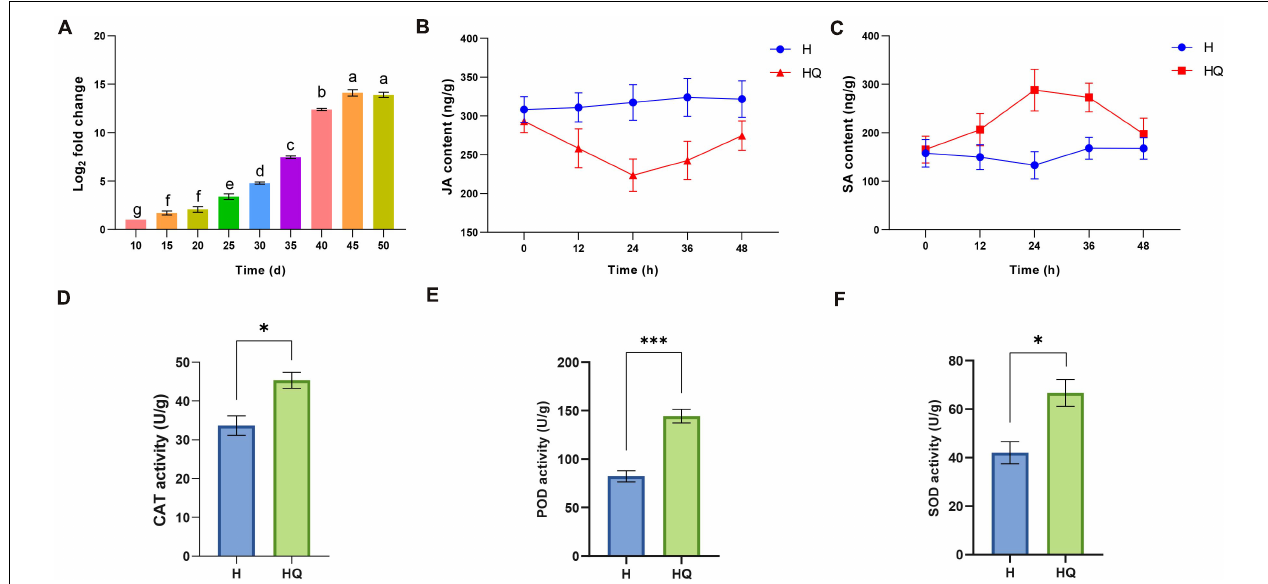
FIGURE 1 | Determination of tomato chlorosis virus (ToCV) content, plant hormones and antioxidant enzyme activity. (A) Accumulation of tomato chlorosis virus in tomato plants at different time points. (B,C) The JA and SA content in control and treatment group. (D–F) The content of CAT, PDO, and SOD in control and treatment group. Values are means ± SE. For each time, means with different letters and asterisk are significantly different ( P < 0.05). H, healthy tomato plants. HQ, tomato plants was fed on by healthy B. tabaci for 24 h. V, tomato plants was inoculated with ToCV. VQ, tomato plants with ToCV that were fed on by healthy B. tabaci for 24